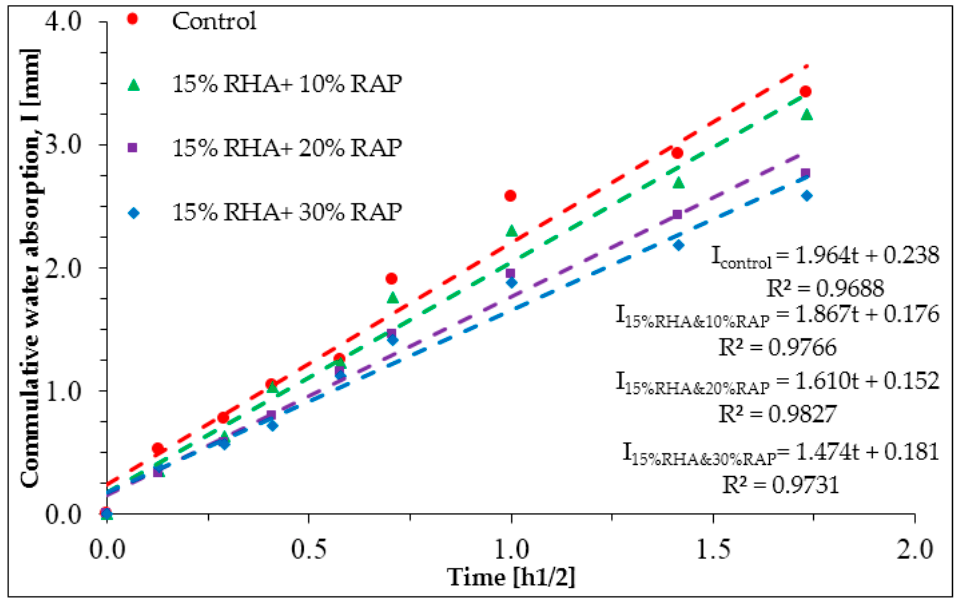
Figure A5. Cumulative water absorption by 15% RHA and (10–30) % RAP-inclusive concrete.